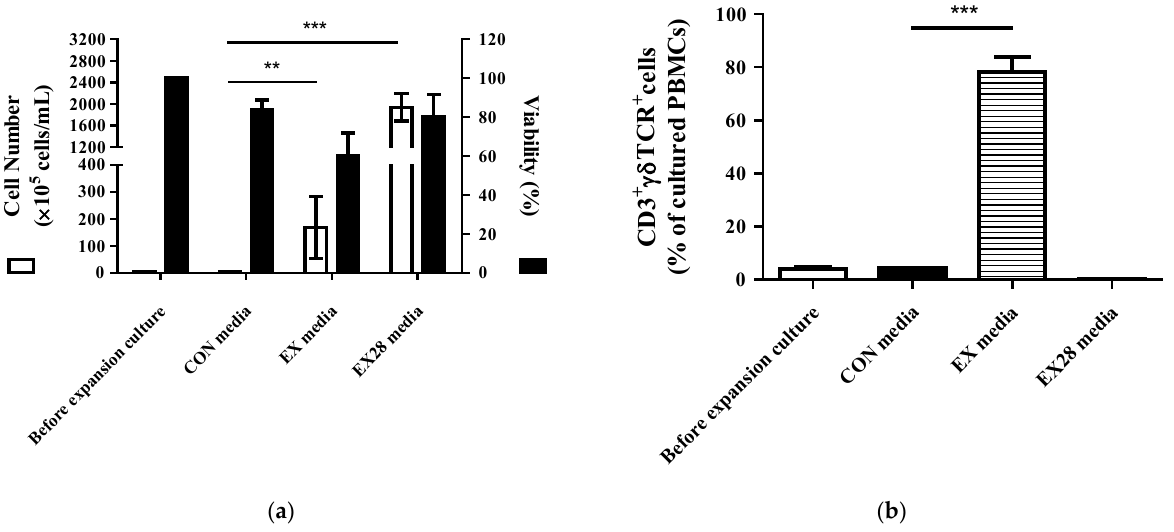
Figure 1. Optimization of human γδ T cell expansion. Peripheral blood mononuclear cells (PBMCs) from healthy donors were cultured in the indicated media. ( a ) Cell proliferation and viability assays. After expansion, the cell count and viability were assessed by trypan blue staining using an automatic cell counter. ( b ) Flow cytometric analysis of CD3 + γδTCR + cell populations. After expansion, single cells were stained and analyzed using the BD FACSCanto II and BD FACSVerse System. The percentages are represented as the mean ± SEM, and statistical significance was determined by comparison with the CON media group (** p < 0.01, *** p <